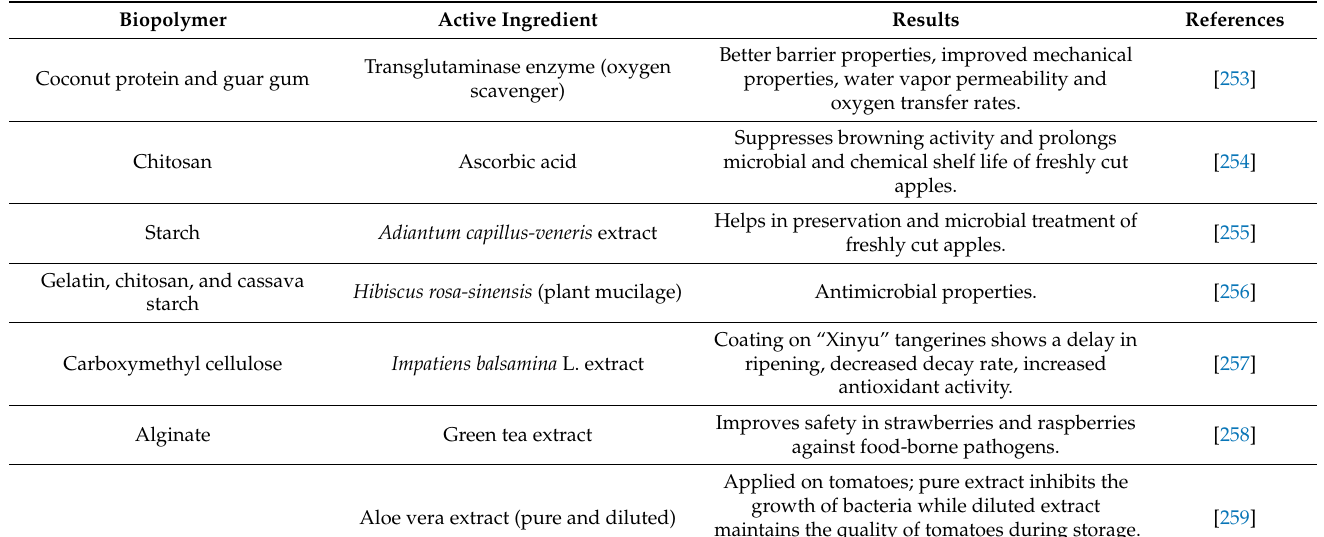
Table 5. Application of edible coatings incorporated with active ingredients and their effects on food